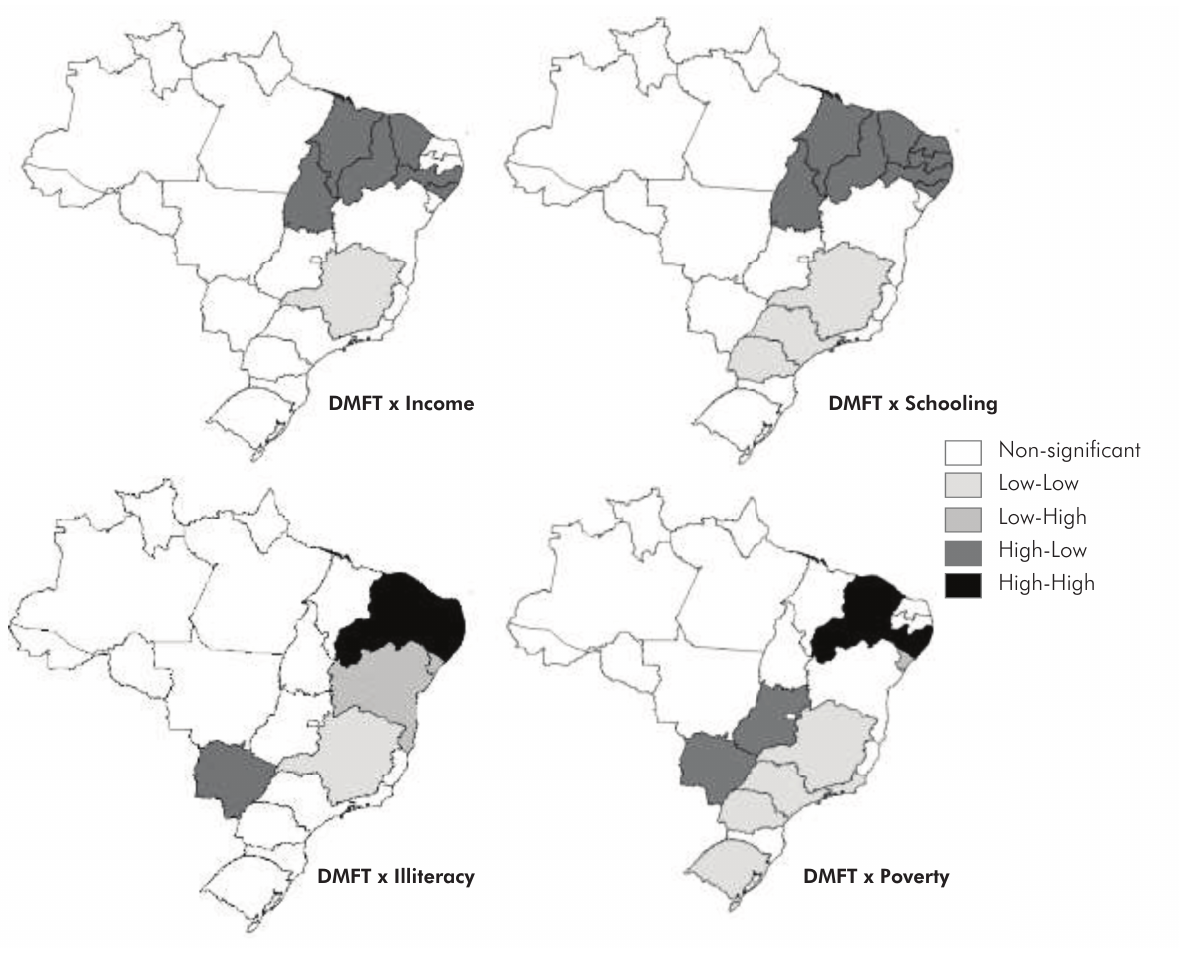
Figure 4. Moran’s map of bivariate analyses between DMFT in 12-year-olds and socioeconomic conditions in